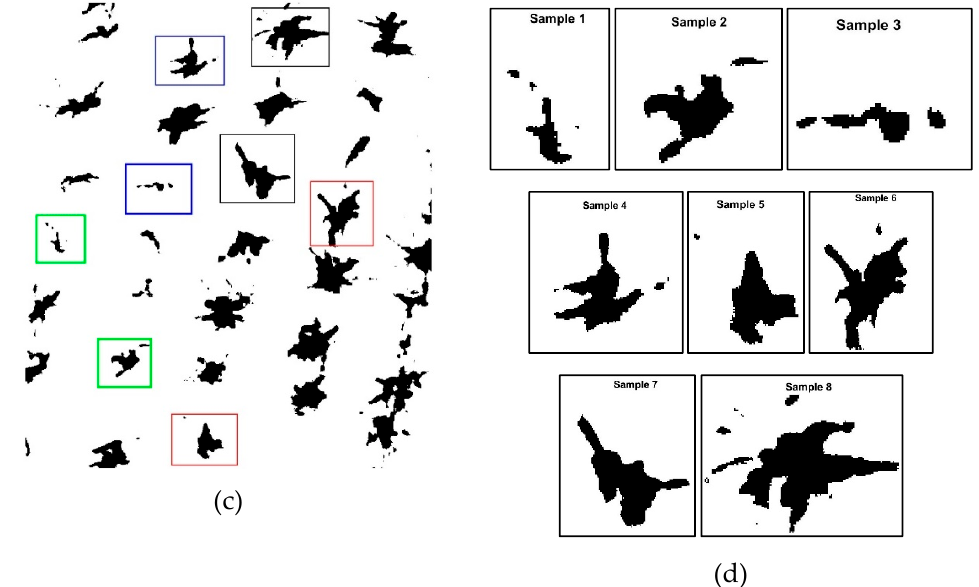
Figure 2. Selection of corn plant samples on the orthomosaic generated using the camera DJI FC6310. ( a ) Selection of samples in the RGB image; ( c ) Samples selected for counting in the a* channel; ( b ) Samples selected in the RGB image; ( d ) Samples with pre-processing in the a* channel of the CIELAB model.